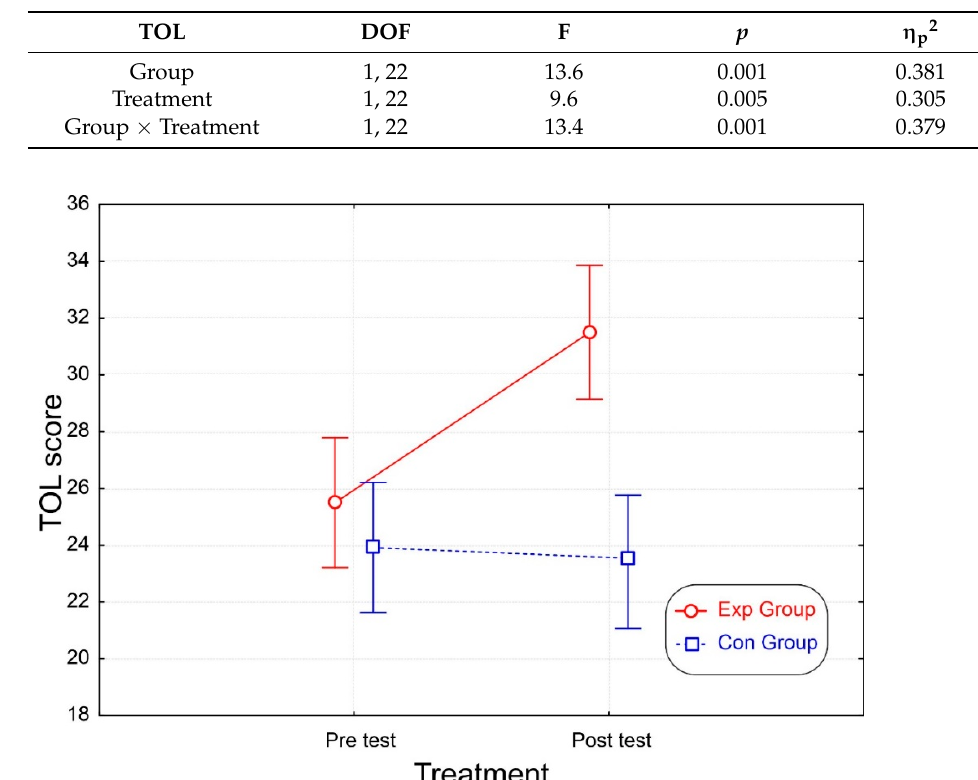
Figure 5. Total score in the TOL test for the two groups before and after the treatment. The vertical bars denote the 95% confidence interval. bars denote the 95% confidence interval.